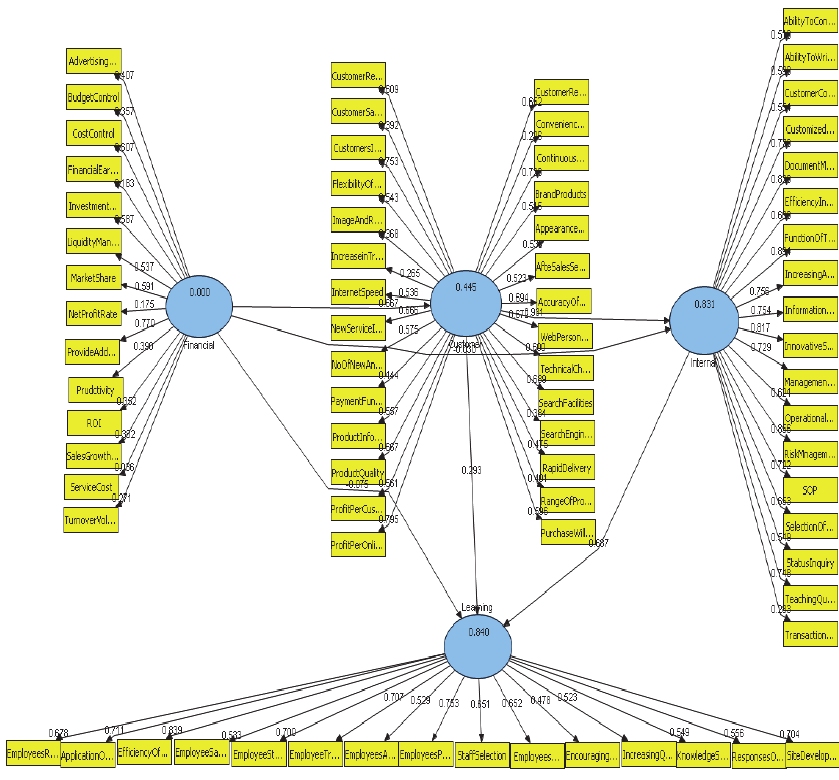
Fig. 5. A theoretical model is verified by the